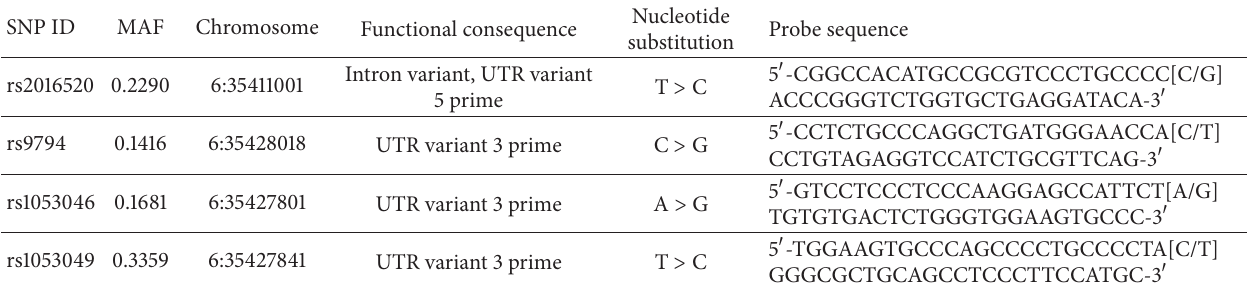
Table 1: Description and probe sequence for 4 SNPs used for Taqman fluorescence probe